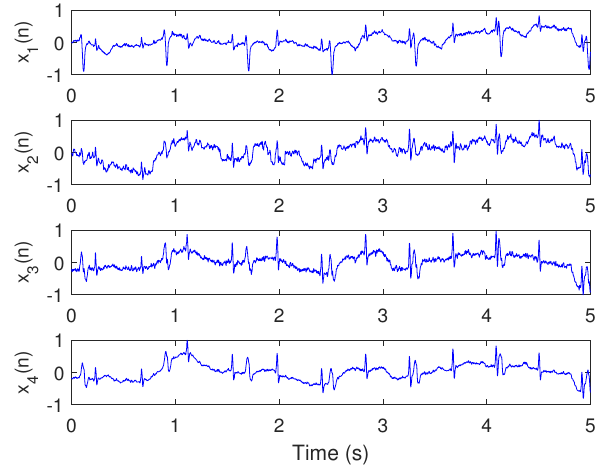
Figure 9. Recorded abdominal ECG signals x 1 ( n ) – x 4 ( n ) from the Physionet Challenge 2013 data set a, file a15, M = 4, N = 5000, f s = 1 kHz, and data samples from 0–4999.